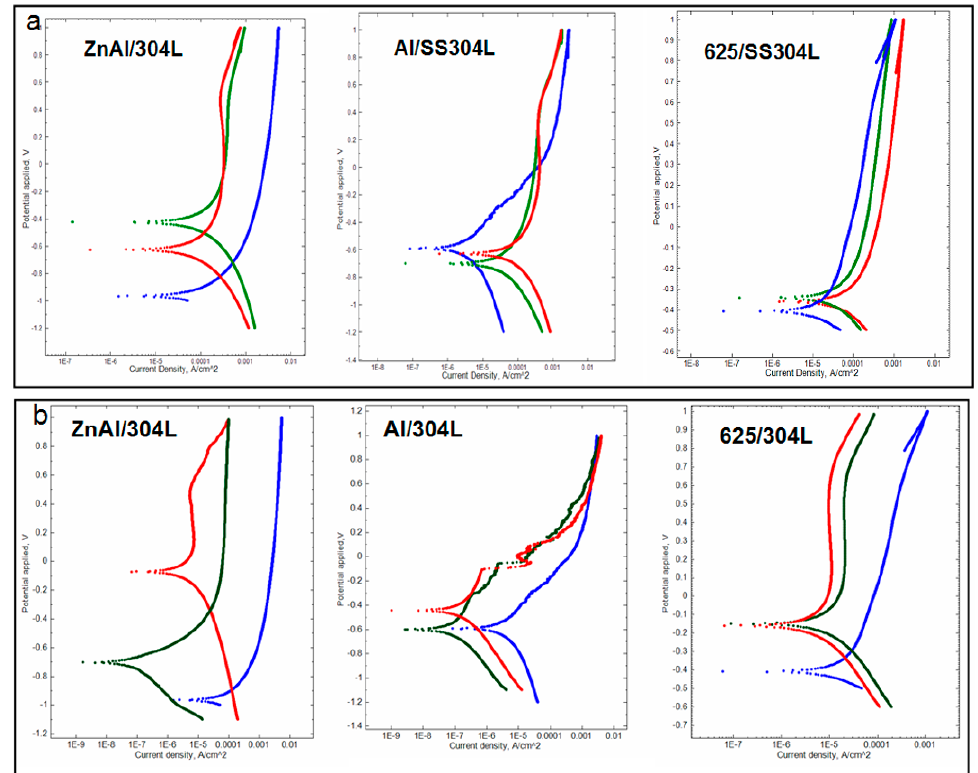
Figure 8. Tafel plots for the thermal spray coatings after: ( a ) NaCl deposition with controlled environmental corrosion; and ( b ) the immersion corrosion test in 3.5 wt % aqueous NaCl solution. The blue, green, and red lines are for 0, 500, and 1000 h, respectively.